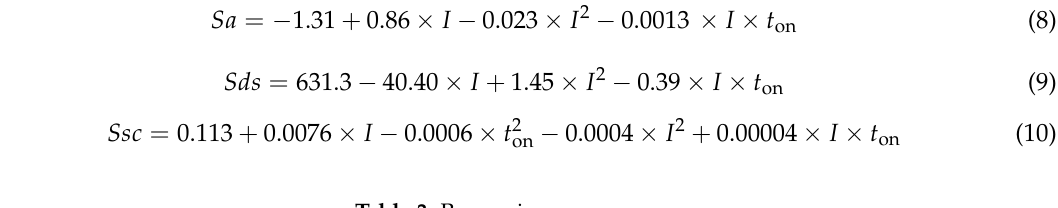
Table 3. Regression summary.